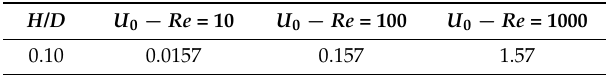
Table 5. Values assumed by velocity at the inlet